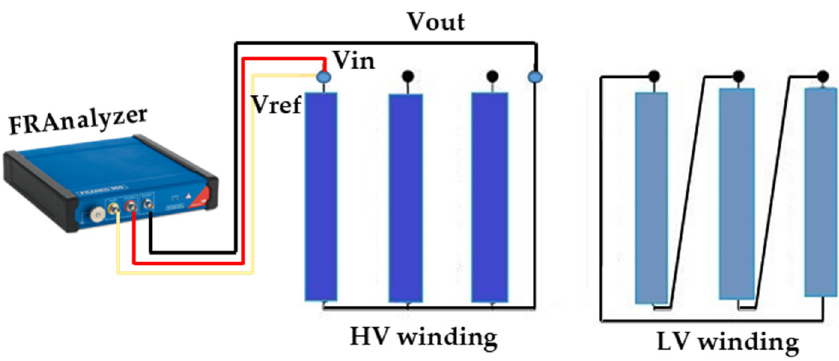
Figure 2. End-to-end winding FRA measurement connection.